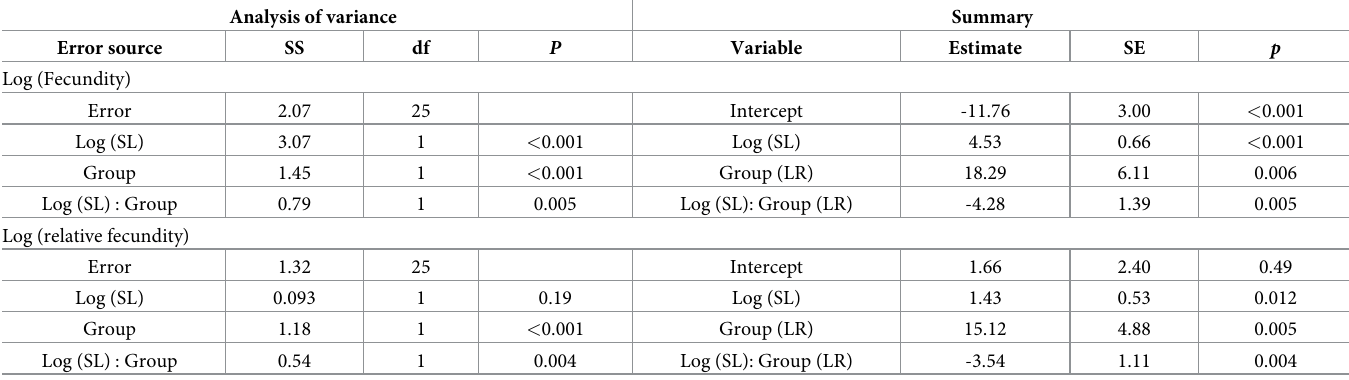
Table 4. Results of the linear model for log (fecundity) or log (relative fecundity) of western sand lance ( Ammodytes japonicus ) in Experiment II. Analysis of